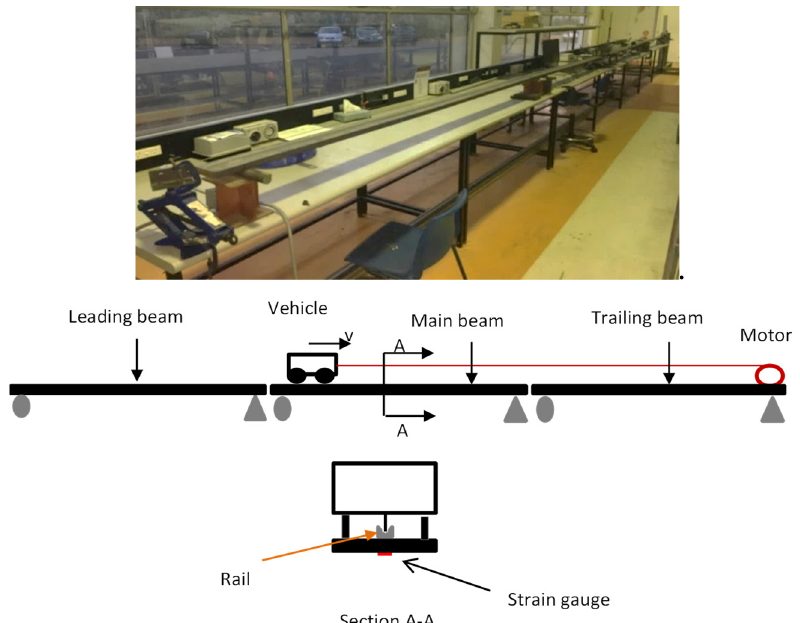
Figure 11. Experimental set-up of the vehicle-bridge system.